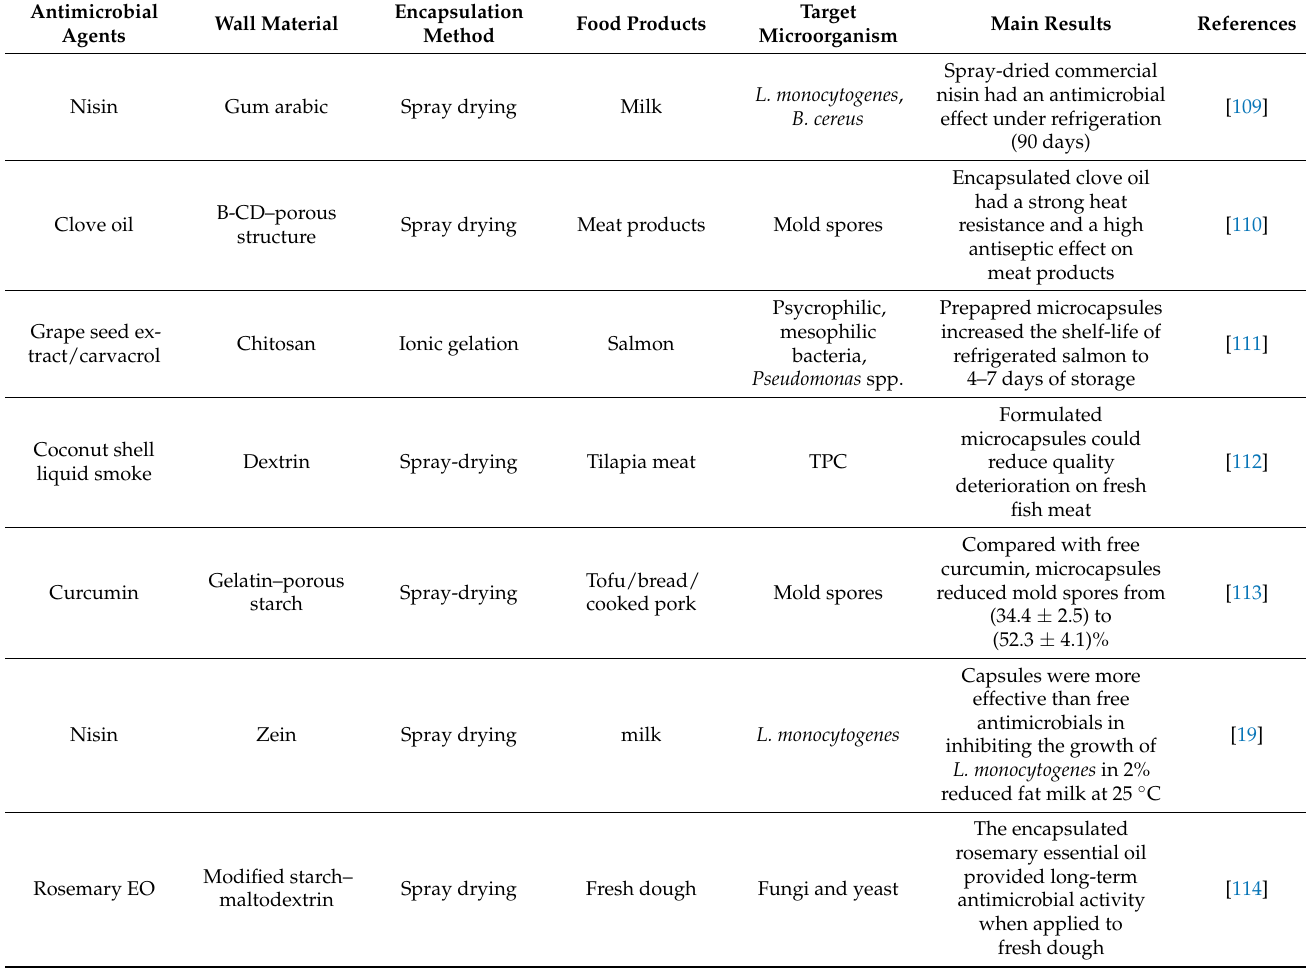
Table 2. Applications of encapsulated antimicrobials for food